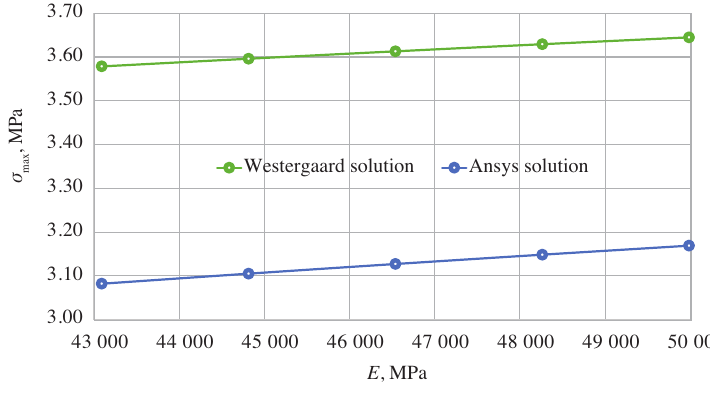
Figure 4. Variation of the concrete